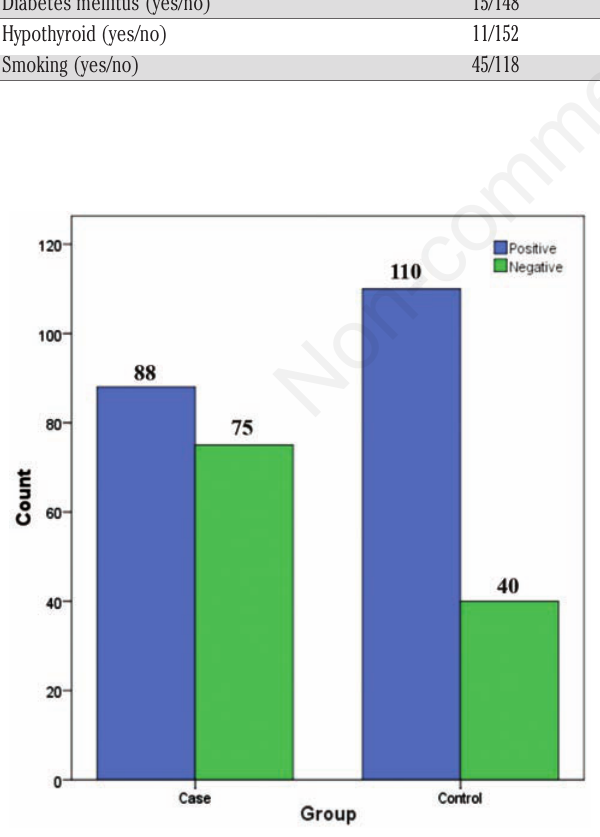
Figure 2. Comparison of anti- Helicobacter pylori test results between conventional and opticospinal multiple